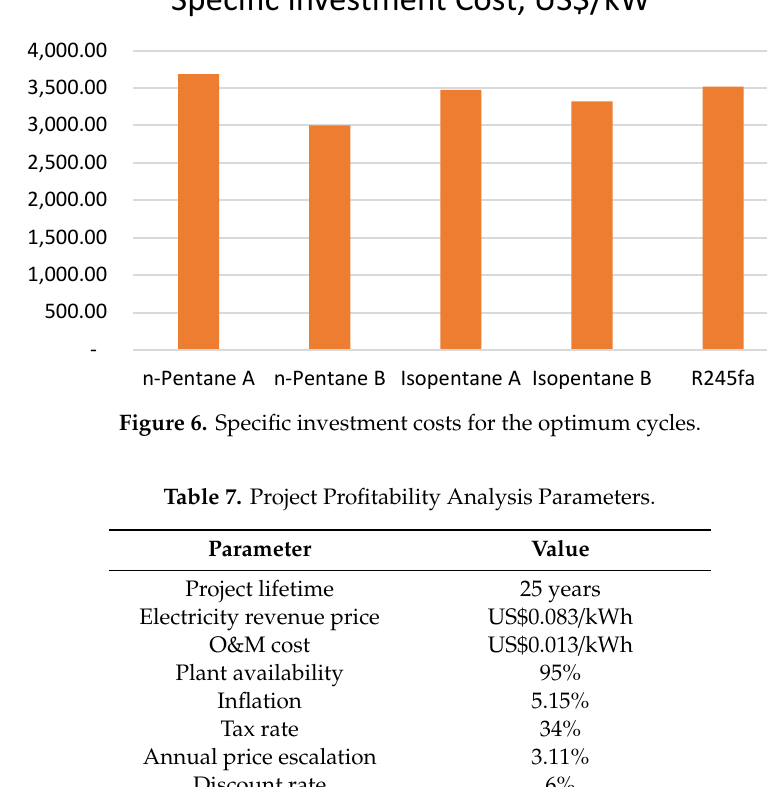
Table 7. Project Profitability Analysis Parameters.